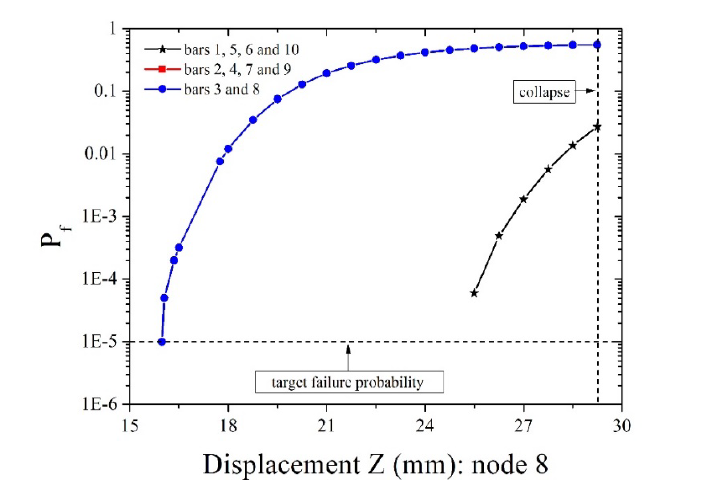
Figure 11. P [f|δ] vs . displacement curve by